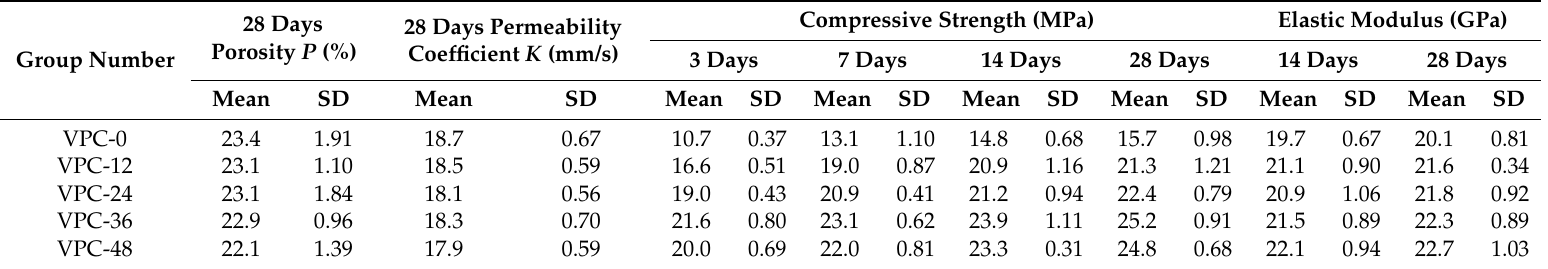
Table 5. Summary of porosity, permeability and mechanical properties of the